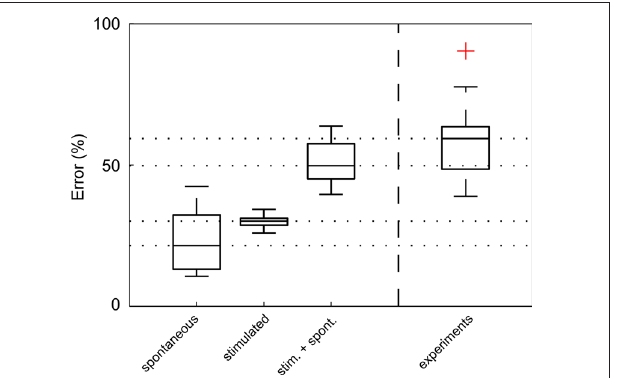
FIGURE 7 | Most of the experimentally observed inter-trial variability can be explained by synapse amplitude variability, spontaneous events and measurement noise. The average ( n = 18) RMSE of inter-trial rel variability of spontaneous activity alone (including measurement noise), derived from experimentally recorded membrane potential fl uctuations prior to stimulation, was calculated to be 22% (spontaneous), which is approximately half of the experimentally measured RMSE (experiments). rel Simulated membrane potential fl uctuations with realistic synaptic variability values alone (without noise) produced a RMSE of 27% (stimulated). rel When spontaneous activity – including spontaneous presynaptic events, spontaneous releases and measurement noise – was added (RMSE = 51%), more than 85% of the average amplitude variability was rel explained. Red cross denotes one